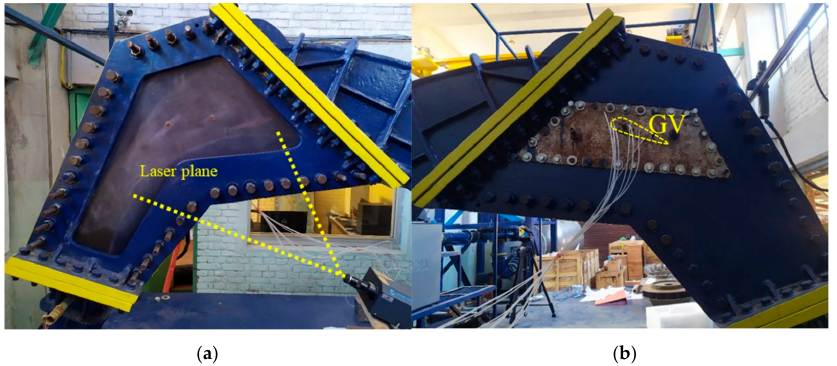
Figure 6. The three-GV test setup for experimental validation: ( a ) Experimental set up which shows the test section in the lab; ( b ) Locations of holes for tapping the value of pressure at GV.